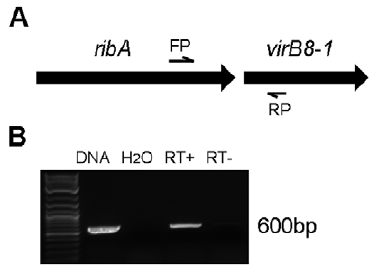
Figure 5. Detection of intergenic region between ribA and virB8- 1 by RT-PCR. cDNA from adult female B. malayi worms was used as the template in PCR reactions. The relative location of the primers (FP, RP) used to detect the intergenic region is shown. (B) Agarose gel showing PCR product resulting from amplification of intergenic region between ribA and virB8-1 . Genomic DNA, water, and reverse transcrip- tase-minus (RT 2 ) samples were included as controls.